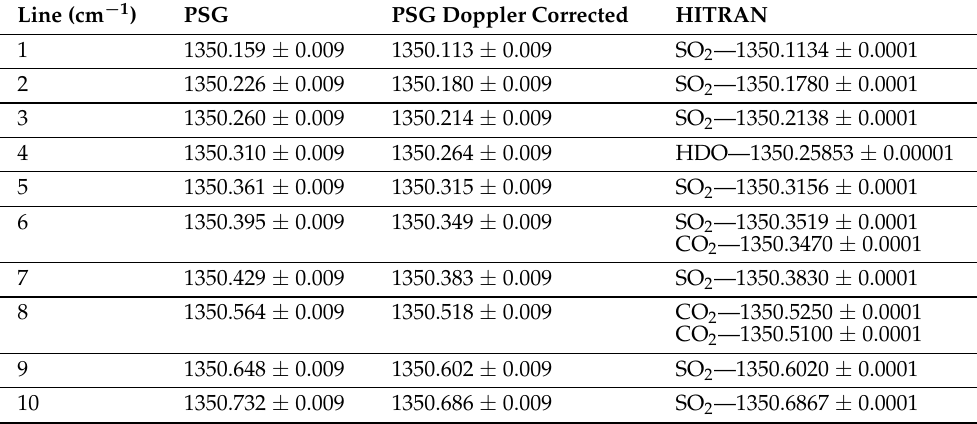
Figure 6. Exploration of the effect of the variation of the abundance of CO 2 , HDO and SO 2 of the model on the Venusian spectrum, at 1350.1–1350.8 cm − 1 , for R = 80,000. ( Top row , left panel ) A decrease in the abundance of CO 2 in the model results in a decrease in the resulting radiance; ( Top row , right panel ) An increase in the abundance of HDO in the model results in an increase in the depth of two lines. This suggests that these lines have a contribution from HDO absorption; ( Bottom row ) An increase in the abundance of SO 2 in the model results in the decrease in the resulting radiance and of the depth of some lines, which suggests that those are SO 2 lines. The error of the simulations is approximately 0.1%. See Table 1 for a list of the lines. Table 1. Sulphur dioxide on Venus—line identification: 1350–1350.8 cm − 1 . The position of the lines agrees with the values from HITRAN [56,64–68]. For line 6, there is more than one possible molecular candidate for the spectral feature. The uncertainty of the line positions in the simulation derive from the resolution of the simulation ( ∼ 0.017 cm − 1